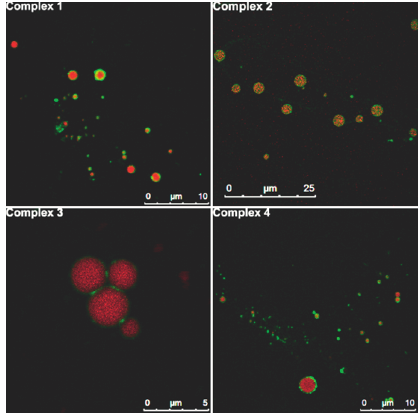
Figure 10. CLSM images of the oil droplet slices of the four complex emulsions produced from FITC-labeled PPI/SSPS complexes and 30 v% oil phase containing